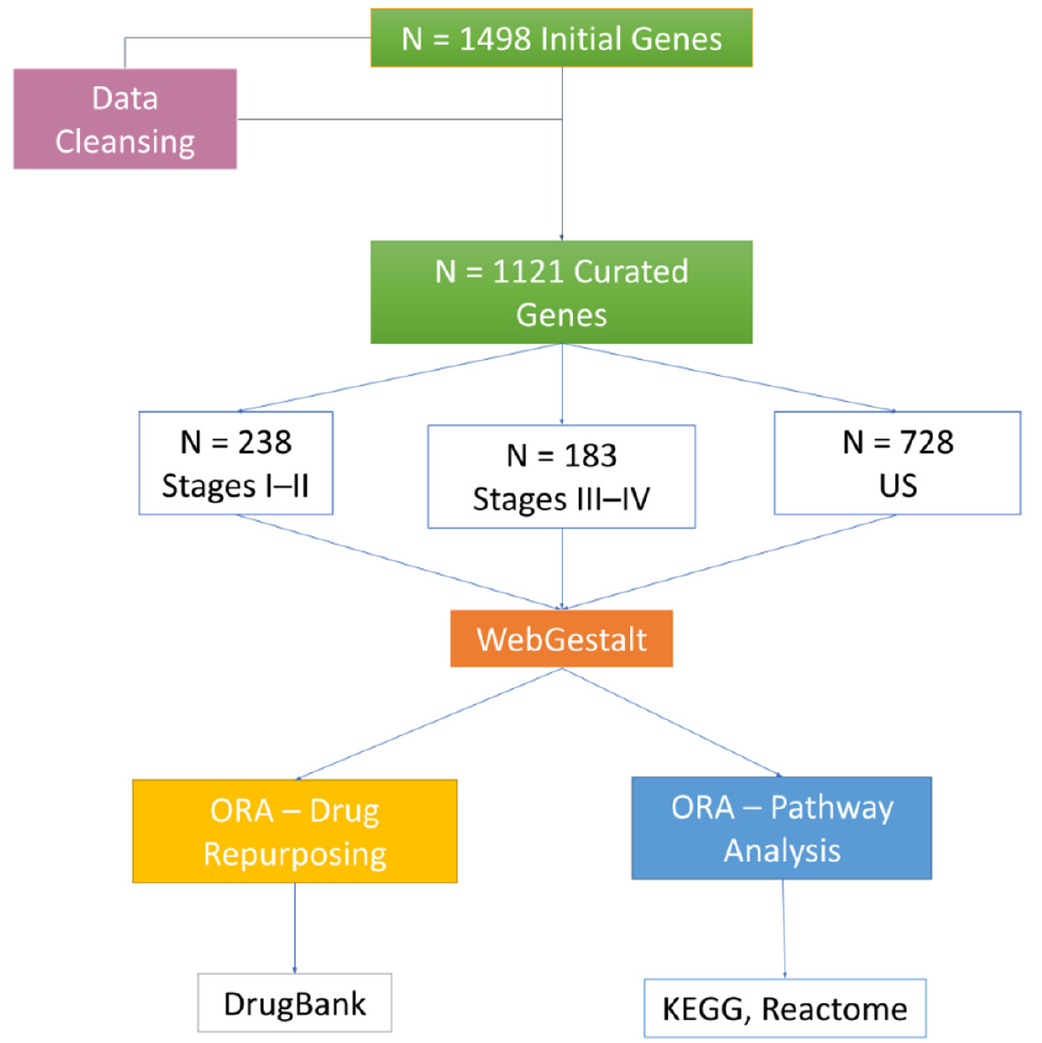
Figure 2. WebGestalt over-representation analysis (ORA) workflow from original seed genes. US: unspecified stages.